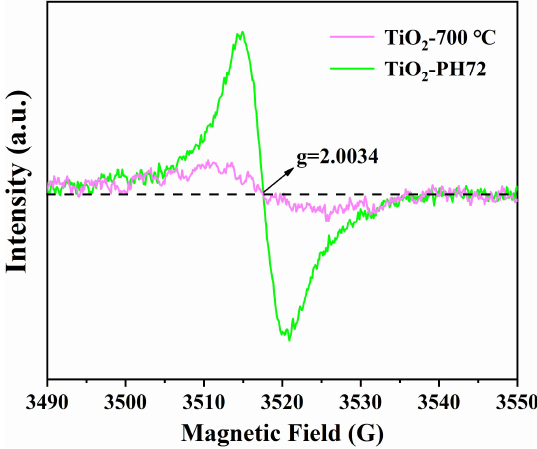
Figure 11. EPR spectra of TiO 2 -700 °C and TiO 2 -PH72. Table 4. The recent literature review on TiO 2 and the comparison between their photocatalytic efficiency and the results in this work.